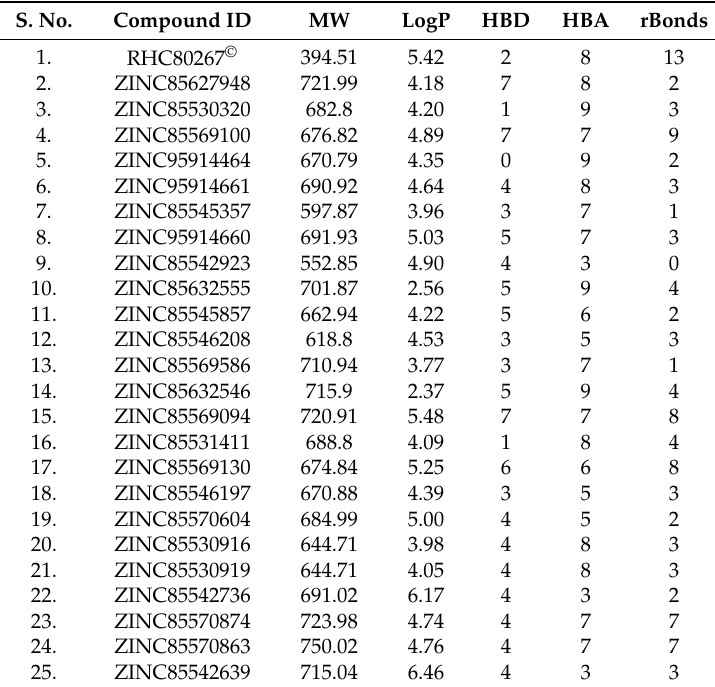
Table 1. Physicochemical properties of the selected compounds *.